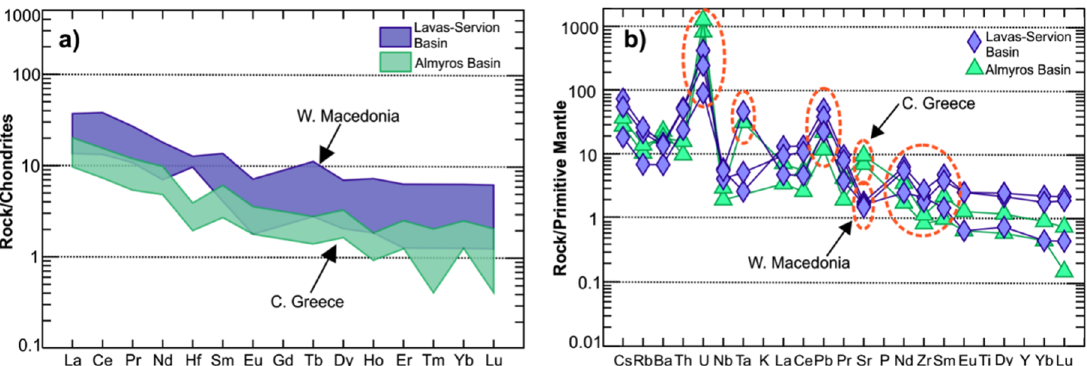
Figure 3. ( a ) Chondrite normalized-REE patterns (Normalization factors after McDonough and Sun, [31] ) from coal samples from Lavas-Servion and Almyros basins (data from Supplementary Materials Table S2), ( b ) Primitive mantle-normalized patterns for samples from Lavas-Servion and Almyros basins (Normalization factors after McDonough and Sun, [31] ).